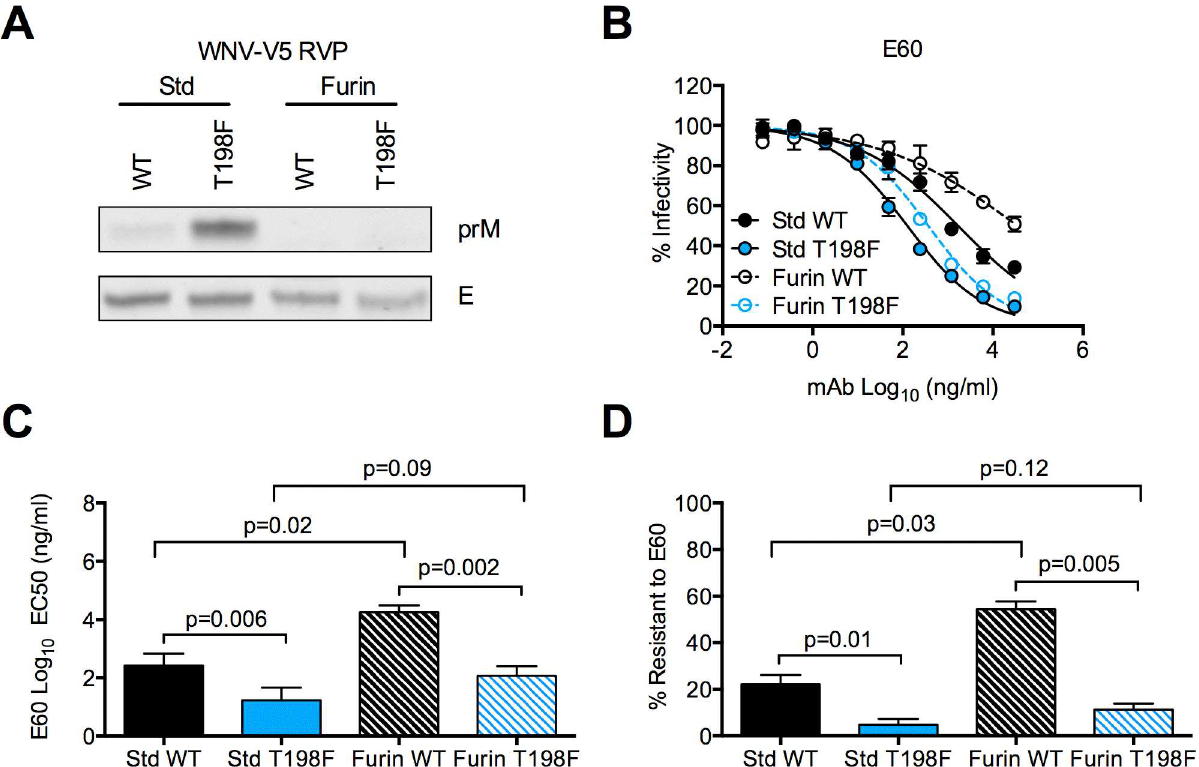
Fig 2. Effect of virion maturation state on neutralization sensitivity of WNV E T198F RVPs. (A) We assessedthe level of V5-tagged prM in WNV RVPs preparedusing standard(Std) conditions, or those increasing the efficiency of prM cleavage(Furin) by SDS-PAGE and Western blotting of pelletedvirions using a mouse monoclonal antibody against V5 (top panel). The level of E protein (bottom panel), as detected by mouse monoclonal antibody,4G2, was used as a loadingcontrolfor each RVP preparation.Data are representative of three independent experiments performed with independentRVP preparations. (B) We concurrently tested Std and Furin preparationsof WT and T198F RVPs for sensitivity to neutralization by mAb E60. Representative dose-response neutralization curves are shown, with the y- and x- axes representing percentinfectivity and mAb concentration, respectively. Infectivity was normalizedto levelsobservedin the absenceof antibody.Error bars indicatethe range of infectivity from duplicateinfections. (C) MeanEC50 valuesfor E60 againstStd or Furin preparations of WT and T198F RVPs. Error bars representthe SEM. The indicatedp-valueswere obtained from pairedt-tests. (D) Mean percentages of Std or Furin WT and T198F RVPs resistant to neutralization at the highestconcentrationof E60 tested (10 μ g/ml).Error bars representthe SEM. The indicatedp-valueswere obtainedfrom pairedt-tests. For (C) and (D) , meanvalueswere obtainedfrom three independent experiments performedin duplicate usingindependent RVP preparations.